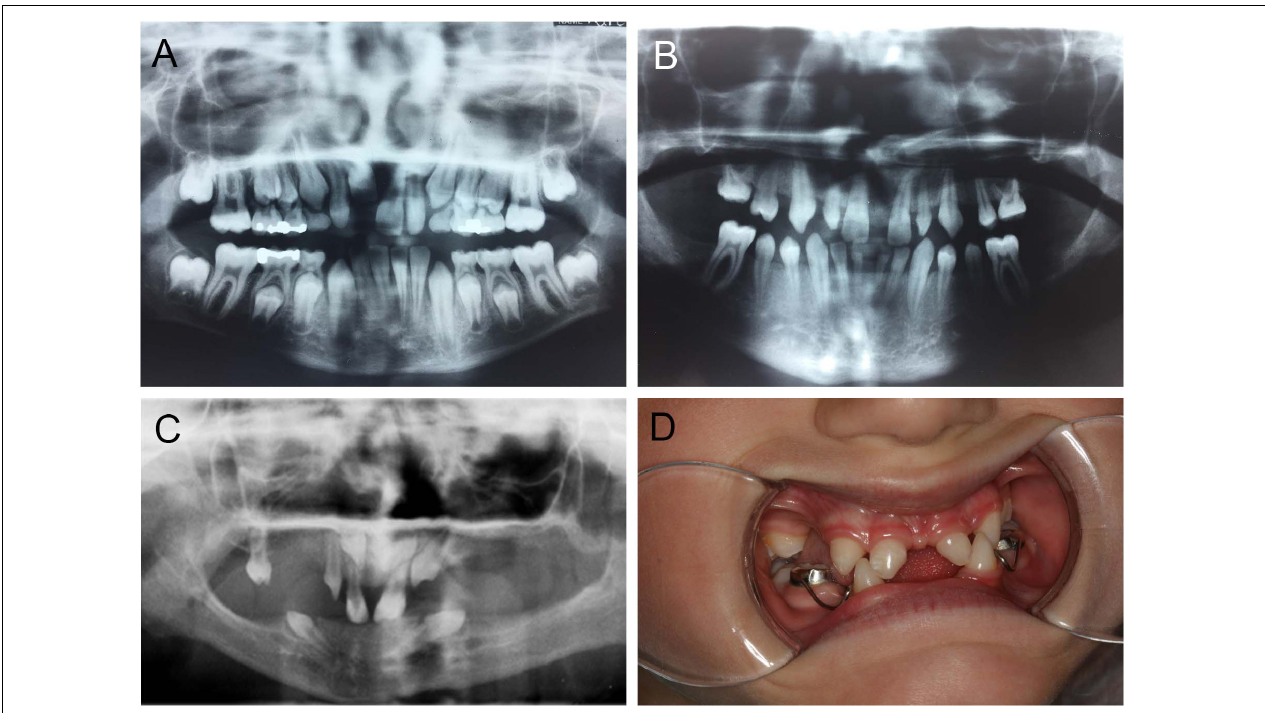
FIGURE 4 | Abnormal tooth appearance, including agenesis of mandibular central incisors, premolars, and molars in a PAX9 mutant patient (B) compared to an unaffected sibling with normal permanent dentition (A) ; 5-year-old patient with a confirmed mutation of EDA gene (XLHED), no permanent teeth in the mandible and only primary canines (never erupted), conical incisors, canines, and one molar noted in the maxilla (C) ; female patient with autosomal recessive (AR) HED, missing mandibular incisors, and first primary molars, as well as maxillary lateral incisors and first primary molars (D)